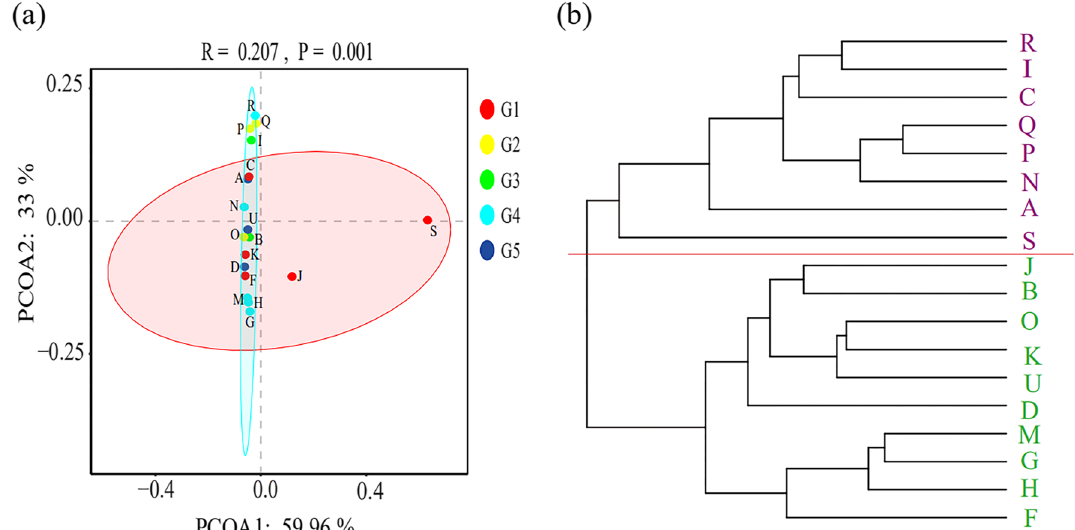
Fig. 3 The dissimilarity of bacterial communities among different groups. a Principal coordinated analysis (PCoA) derived from dissimilarity matrix of Bray–curtis distance of five groups. An analysis of similarities (ANOSIM) was calculated at the OTU level based on Bray–Curtis distance, indicating community similarity across sampling groups. b The Bray–curtis based cluster analysis of bacterial community composition among plant species